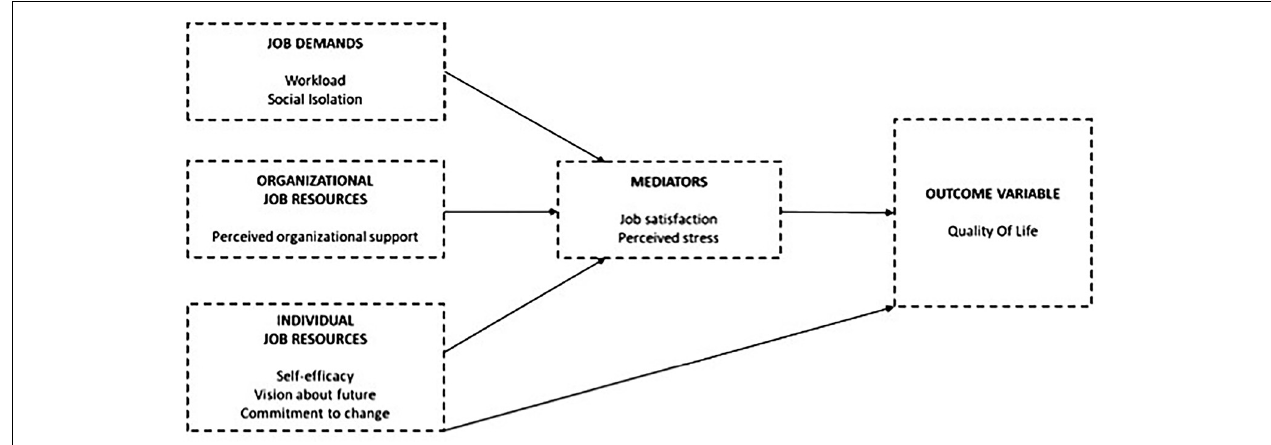
FIGURE 1 | Hypothesized conceptual framework. A hybrid model for Quality of Life in a Latent Path Analysis